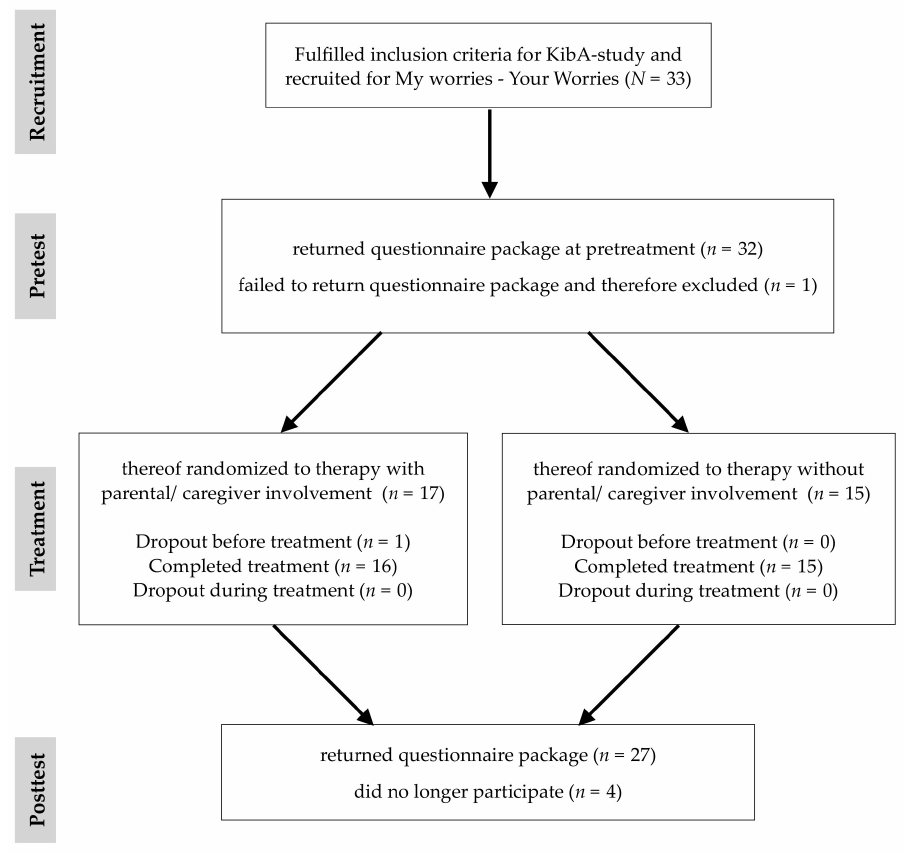
Figure 1. Study Flow